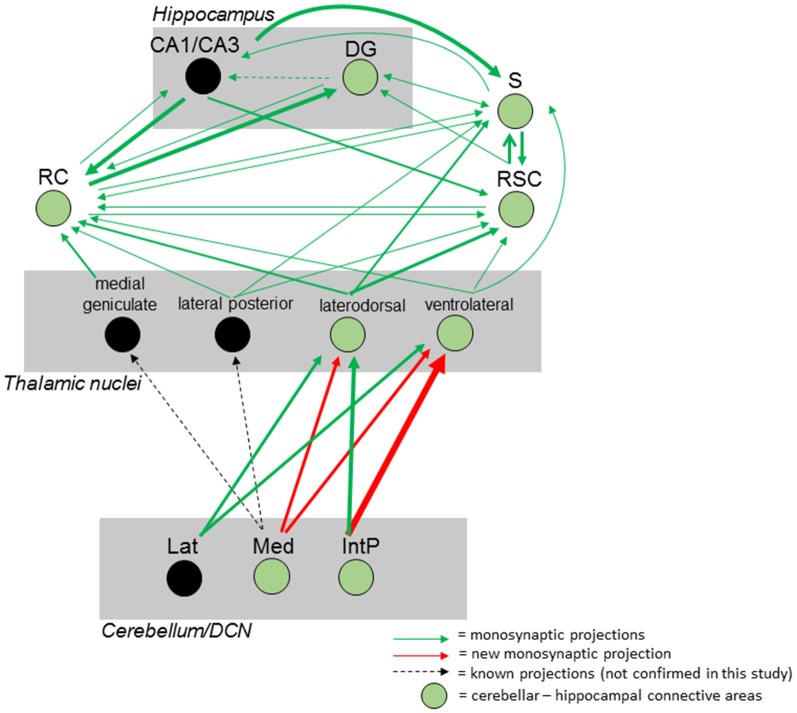
Summary of the mouse cerebellar-hippocampal circuit. Known (black arrows) and observed (green) monosynaptic projections between the cerebellum and hippocampus via the thalamus, retrosplenial (RSC) and rhinal (RC) cortices and/or subiculum (S). A step by step injection of rabies virus started in the DG confirmed monosynaptic input from S, RC and RSC. While the S projects to and receives input from CA1/CA3 and DG, RSC, and RC, monosynaptic input was confirmed from the laterodorsal, ventrolateral and lateral posterior thalamic nuclei. Injections in the RSC confirmed monosynaptic input from these thalamic nuclei, too. By injecting these thalamic nuclei, new monosynaptic projections (red arrows) from the medial cerebellar nucleus to the laterodorsal and ventrolateral thalamus, as well as a new monosynaptic projection from the posterior interpositus cerebellar nucleus to the ventrolateral thalamus were identified in this study. Injecting the RC confirmed additional monosynaptic input from the medial geniculate thalamic nucleus which was not injected with rabies and can only be hypothesized to connect the cerebellum with the hippocampus (black circles). Thickness of arrows indicate strength of observed projections. IntP, posterior interposed cerebellar nucleus; Lat, lateral (dentate) cerebellar nucleus; Med, medial (fastigial) cerebellar nucleus; DG, dentate gyrus; S, subiculum; RC, rhinal cortex; RSC, retrosplenial cortex.